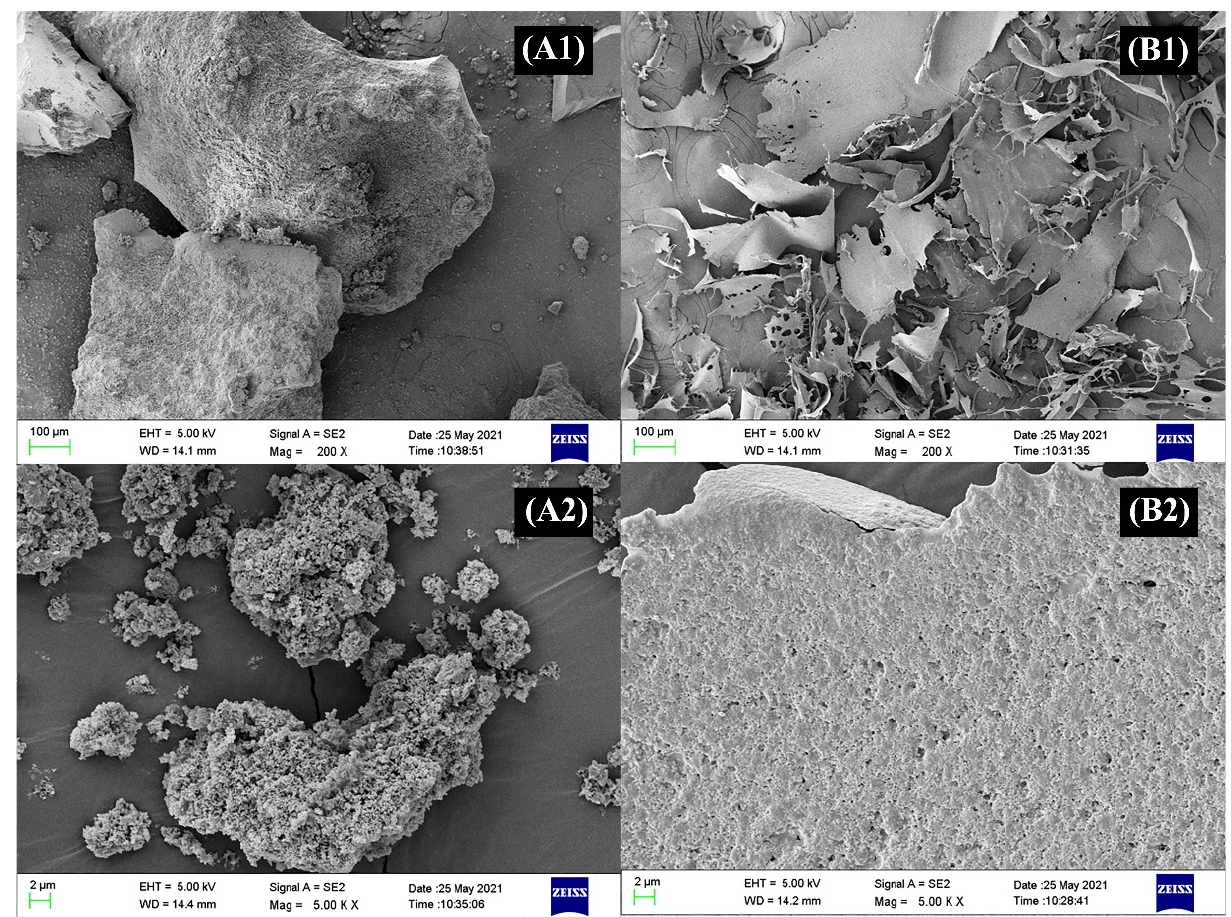
Figure 3. SEM images of ( A1 , A2 ) PSP and ( B1 , B2 ) PSP − Zn.